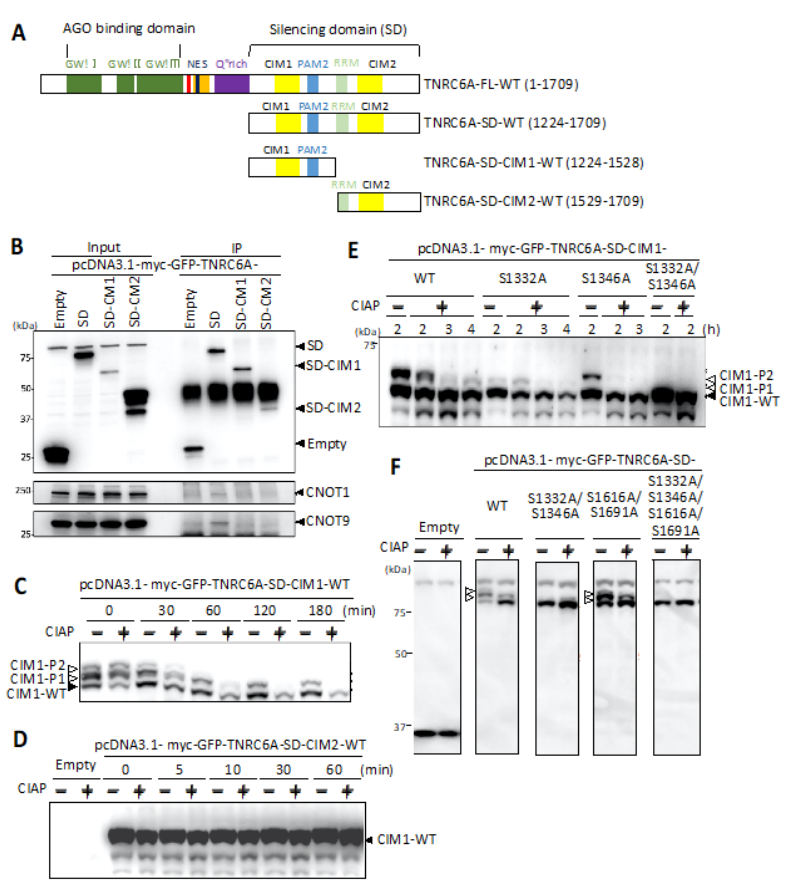
Figure 2. Interaction between the TNRC6A silencing domain (SD) and CNOT1/CNOT9 and identification of phosphory- lated amino acids in TNRC6A-SD. ( A ) Domain structures of TNRC6A and fragments of the SD used for analysis of phos- phorylation. ( B ) Cell lysates of HeLa cells expressing GFP-tagged TNRC6A-SD, TNRC6A-SD-CIM1, or TNRC6A-SD-CIM2 protein were immunoprecipitated with anti-GFP antibody, and CNOT1 and CNOT9 were detected using anti-CNOT1 and anti-CNOT9 antibody, respectively. ( C ) Phosphorylation patterns of the TNRC6A-SD-CIM1 fragment with and without phosphatase (calf intestine alkaline phosphatase (CIAP)) treatment for 0, 30, 60, 120, or 180 min were detected by the Phos- tag gel shift assay. ( D ) Phosphorylation patterns of the TNRC6A-SD-CIM2 fragment with and without CIAP treatment for 0, 5, 10, 30, or 60 min were detected by the Phos-tag gel shift assay. ( E ) Phosphorylation patterns of the TNRC6A-SD-CIM1 fragments with no mutation, S1332A, S1346A, or S1332A/S1346A with and without CIAP treatments for 2, 3, or 4 h were detected by the Phos-tag gel shift assay. ( F ) Phosphorylation patterns of the TNRC6A-SD fragments with no mutation, S1332A/S1346A, S1616A/S1691A, or S1332A/S1346A/S1616A/S1691A with and without CIAP treatment for 2 h were de- tected by the Phos-tag gel shift assay.